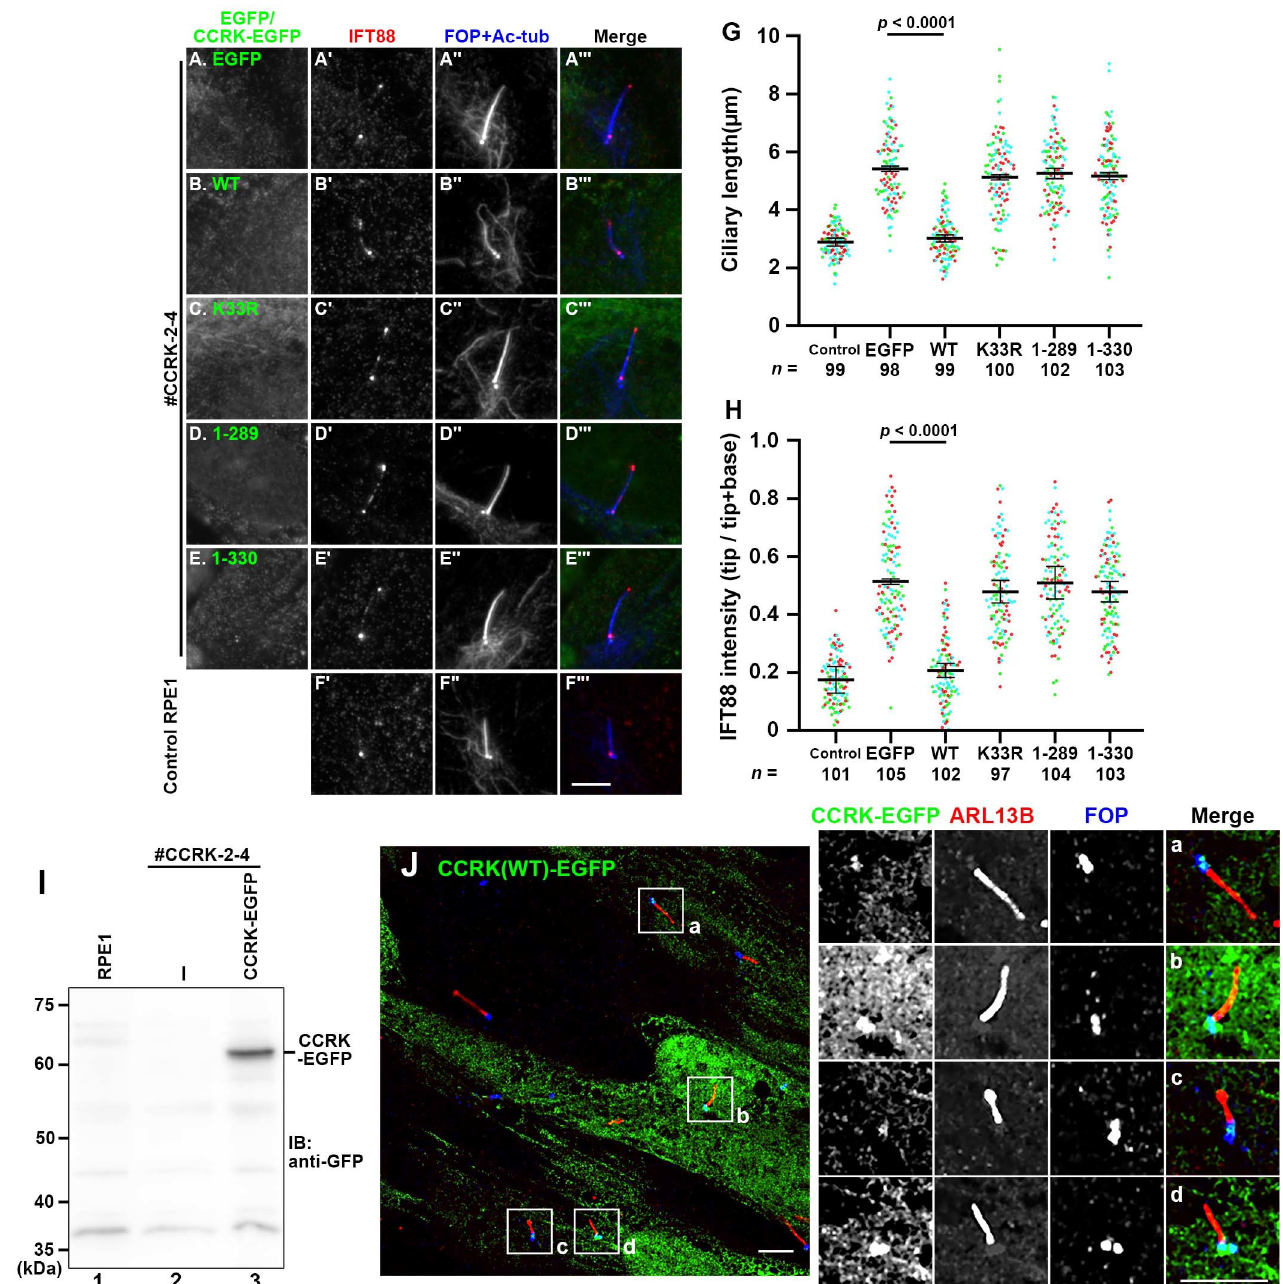
Fig 5. Kinase activity of CCRK and its interaction with BROMI are required for its functions. (A–E) CCRK -KO cells (#CCRK-2-4) stably expressing EGFP (A), or EGFP-fused CCRK(WT) (B), CCRK(K33R) (C), CCRK(1–289) (D), or CCRK(1–330) (E), or control RPE1 cells (F) were immunostained for EGFP (A– E), IFT88 (A 0 –F 0 ), and FOP+ Ac-tubulin (A 00 –F 00 ). (G) Ciliary lengths of cells shown in (A 00 –F 00 ) were measured and expressed as scatter plots. (H) The relative staining intensity of IFT88 at the ciliary tip and base in cells shown in (A 0 –F 0 ) were estimated, and the intensity ratios of tip/(tip+ base) were expressed as scatter plots. Different colored dots represent three independent experiments, horizontal lines indicate the means, and error bars are the SDs. Statistical significances were calculated using one-way ANOVA followed by the Dunnett’s multiple comparison test. (I) Lysates prepared from control RPE1 cells (lane 1), CCRK -KO cells (#CCRK-2-4) (lane 2), or CCRK -KO cells stably expressing CCRK(WT)-EGFP (lane 3) were processed for immunoblotting analysis using anti-GFP antibody. (J) Confocal microscopy image of CCRK-KO cells (#CCRK-2-4) stably expressing CCRK(WT)-EGFP. The cells were fixed, permeabilized, incubated with anti-ARL13B and anti-FOP antibodies, and observed using a confocal microscope as described in Materials and methods. The boxed regions (a–d) were 2.5-fold magnified and shown at the right. Scale bars, 5 μ m.